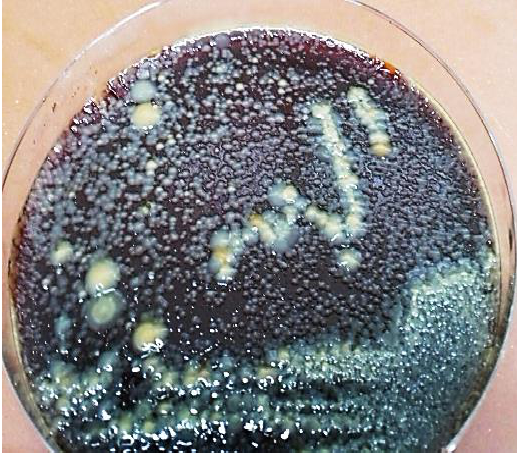
Figure 1. Heavy growth of A. hydrophila on modified ampicillin sheep blood agars